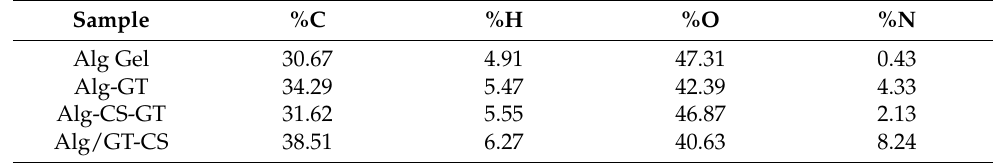
Table 1. Elemental analysis results of Alg Gel, ALG-GT, ALG-CS-GT and